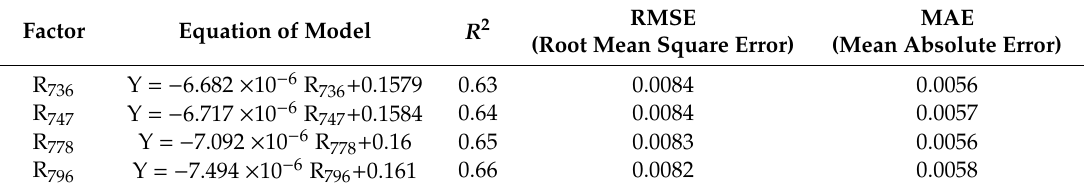
Table 4. Simple linear inversion model and the accuracy.